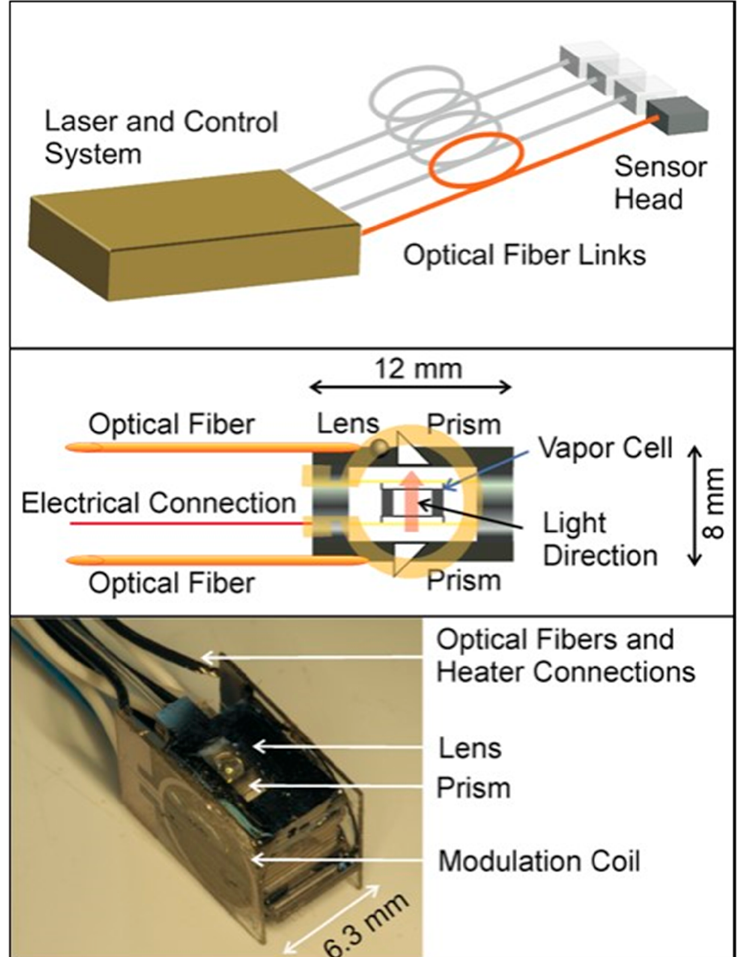
Figure 20. NIST micro-fabricated magnetometer (2012). Reprinted from Ref [103]. In 2017, NIST implemented magnetic field imaging utilizing an OPM-MEMS mag- netometer with a probe cross-section of less than 1 cm 2 and a classical cantilever beam vapor cell structure [106], as shown in Figure 21, with a peripheral structure of 7.3 × 7.3 × 3.7 mm 3 and an internal vapor cell of 1.5 × 1.5 × 1.5 mm 3 , by utilizing a laser-heated vapor cell technique, with a pumping light and heating light. Both the pumping and heating lasers were introduced by optical fibers (25 arrayed probes, using two distributed feedback laser (DFB) lasers and eight 1.5 µ m lasers as the pumping and heating lasers, respectively). The micro-fabricated probes were light-pumped magnetometers with multiple modes, mainly in the zero-field mode. A total of 33 probes were assembled for the experiments, excluding the probes with a higher heating power and poor sensitivity, to conduct magnetic exper- iments on the brain for 21 probes with the best index. The full-field mode (Bell–Bloom magnetometer [107]) works in a geomagnetic environment and achieved a sensitivity test of 3 pT/Hz 1/2 with a bandwidth of 1 kHz. This article has notable significance for the study of magnetometer arrays with the DBR laser-splitting scheme. A small-volume, arrayed fiber-coupled light-pumping atom magnetometer allows the sensor to have more flexibility in placement and density; this feature makes them very suitable in the imaging of various magnetic field sources, especially in applications in